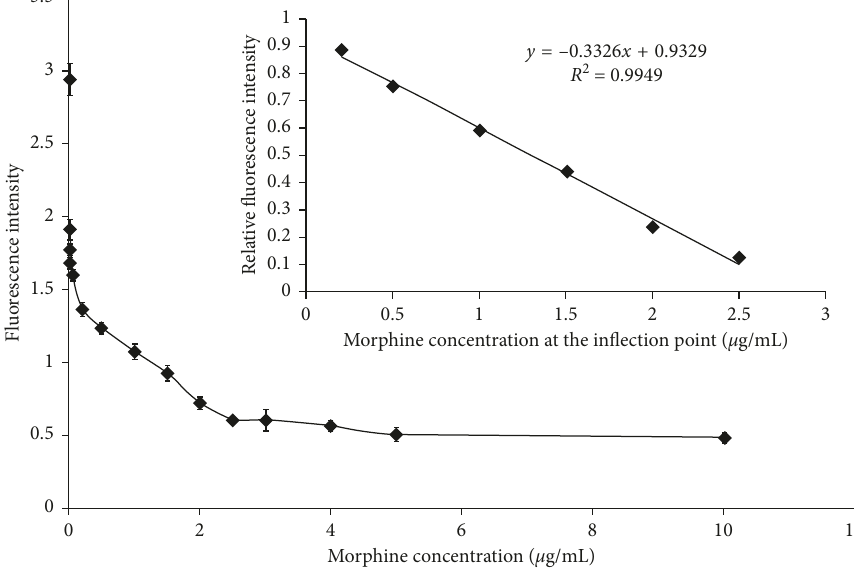
Figure 9: Competition curve of MOR, and MOR standard quantitative curve (insert).